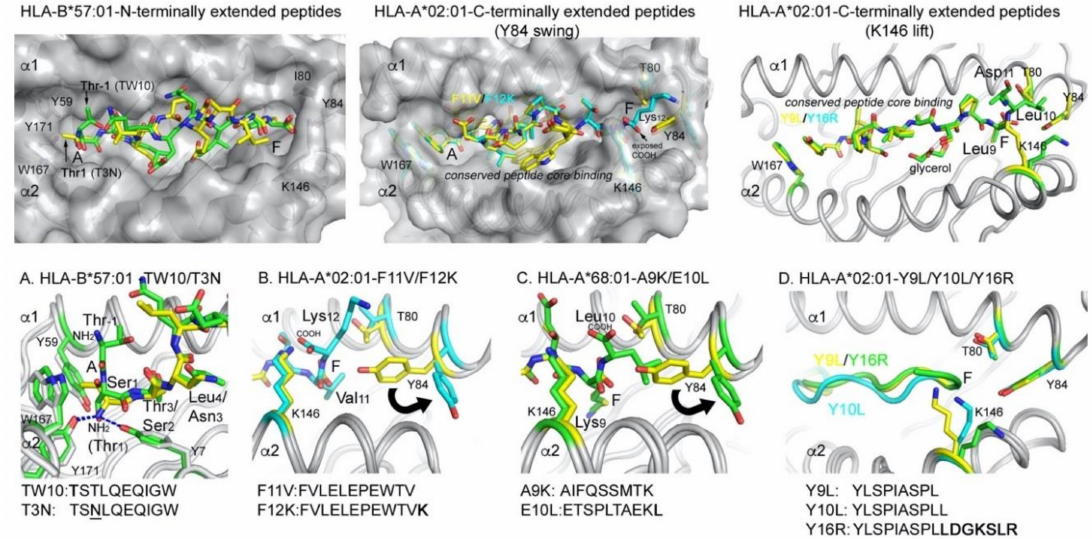
Figure 4. Presentation modes of N- and C-terminally extending peptides by MHC I alleles. N-terminally extending peptides undergo a structural change that allow them to protrude from the A pocket (top row, left panel), while C-terminally extending peptides instead induce a structural change in the MHC I molecule that opens the F pocket (top row, middle and right panel). ( A ) Comparison between a the conventionally presented peptide T3N (yellow, PDB 5T70) with the extending peptide TW10 (green, PDB 5T6X). ( B ) Tyr84 swing mechanism of HLA-A*02:01 with a C-terminally extended positively charged residue (peptide F12K as cyan sticks, PDB 5DDH), compared to the conventional F11V peptide (yellow sticks, PDB 5D9S). ( C ) Tyr84 swing mechanism of HLA-A*68:01 with a C-terminally extended hydrophobic residue (peptide E10L as green sticks, PDB 6EI2) compared to the conventionally presented A9K peptide (yellow, PDB 4HWZ). ( D ) Lys146 lift mechanism following negatively charged amino acid addition. Structures containing core peptides in yellow (peptide Y9L, PDB 5F9J), extending peptides in green (Y16R, PDB 5FA4) and cyan (Y10L, PDB